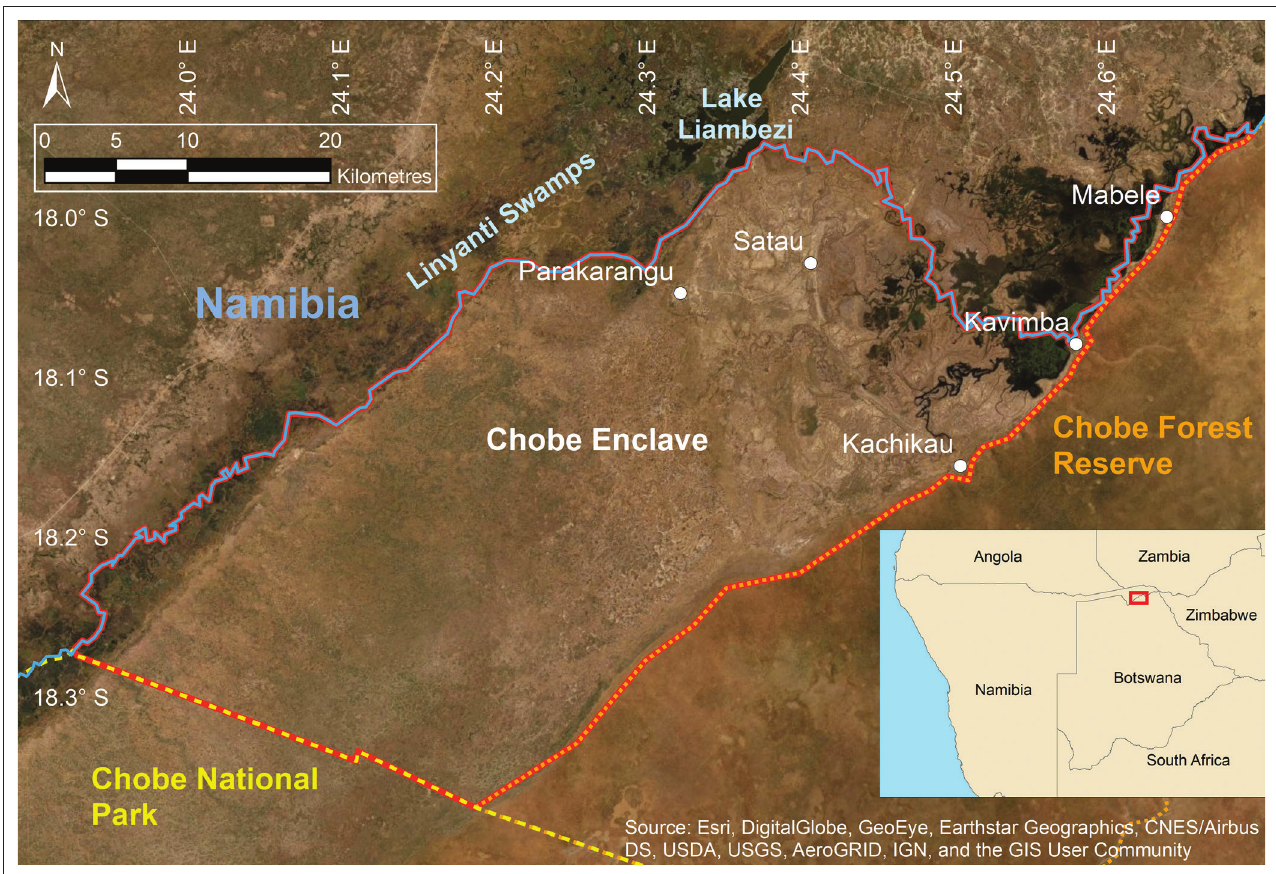
FIGURE 1: Location of the Chobe Enclave in Botswana (delimited by the red rectangle in inset), between Namibia in the north and west, Chobe National Park in the south and Chobe Forest Reserve in the east. The limits of the Chobe Enclave are delineated by the red line, including the border with Namibia, which follows the Linyanti River (in